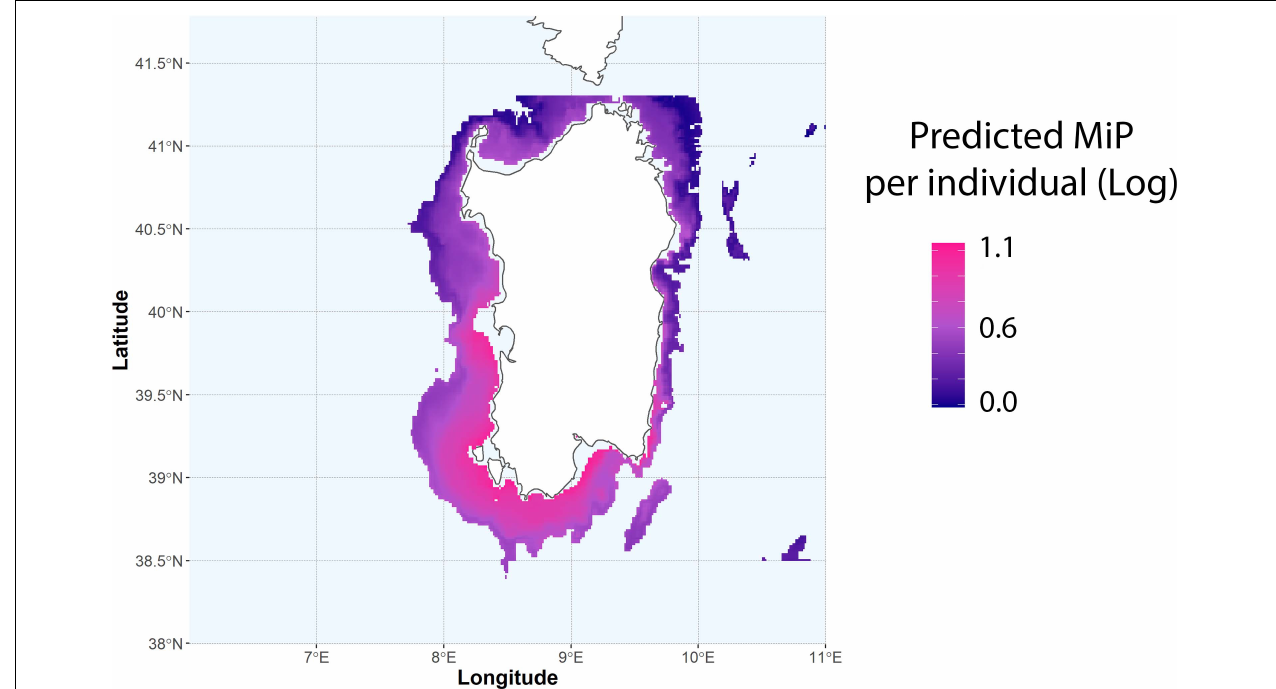
FIGURE 6 | Predicted values of MiP per individual according to the GAM model based on depth and distance from plastic hotspots. Predicted values are on